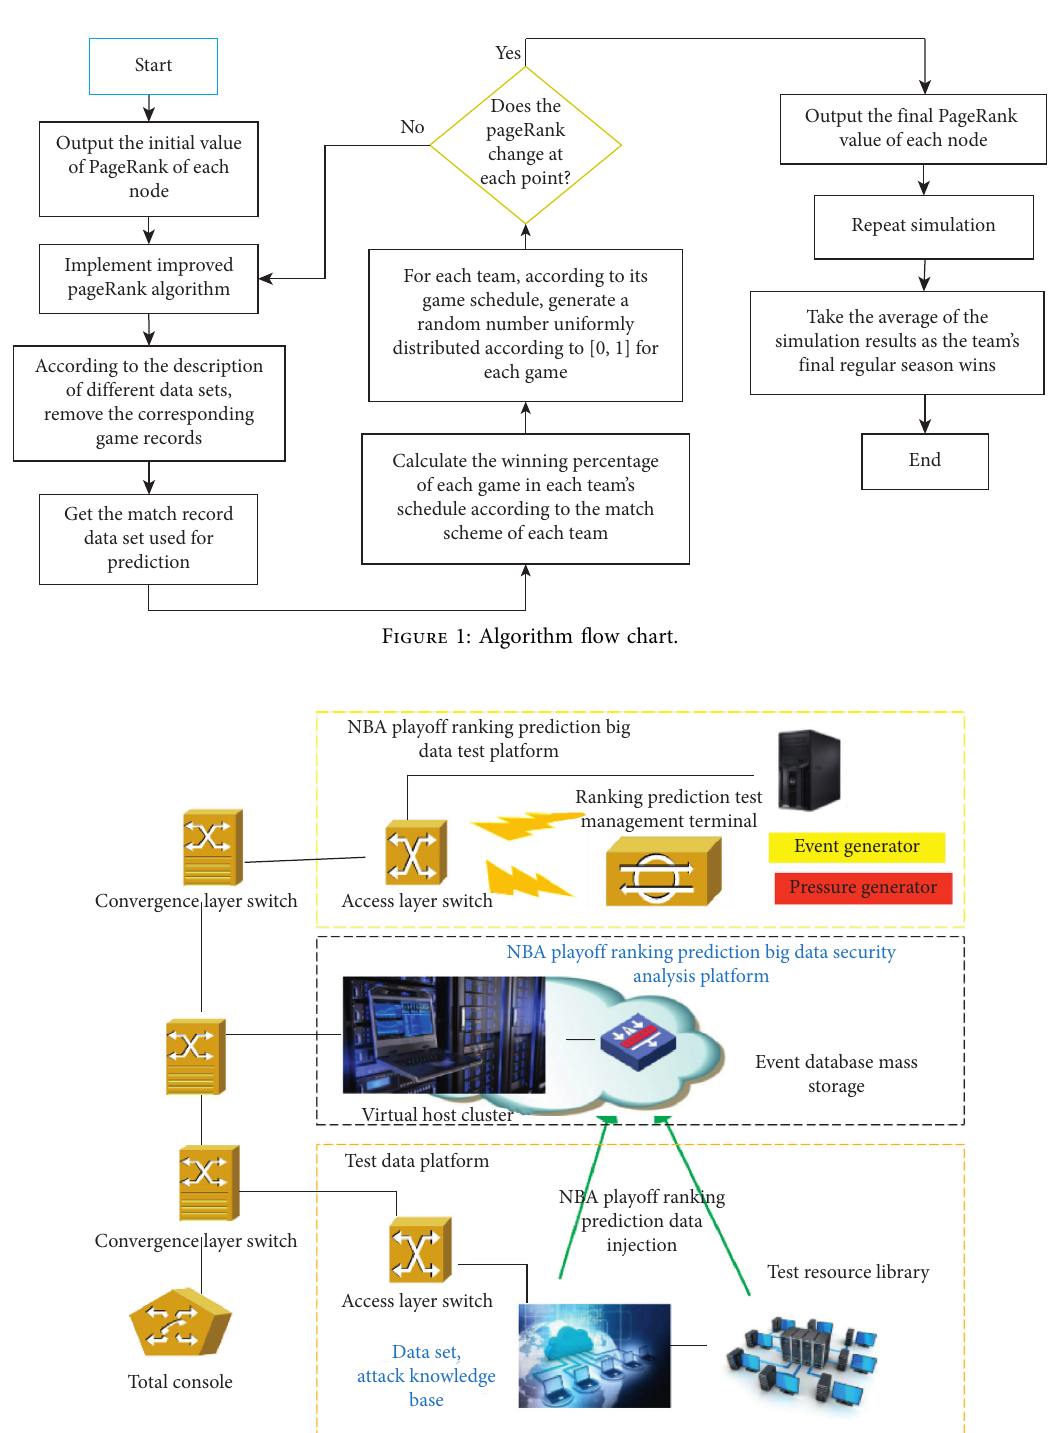
Figure 2: NBA playoff ranking prediction big data